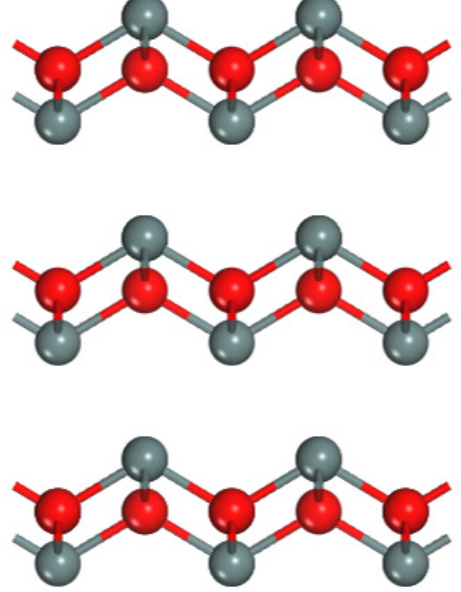
Figure 7. Crystal structure of stannic